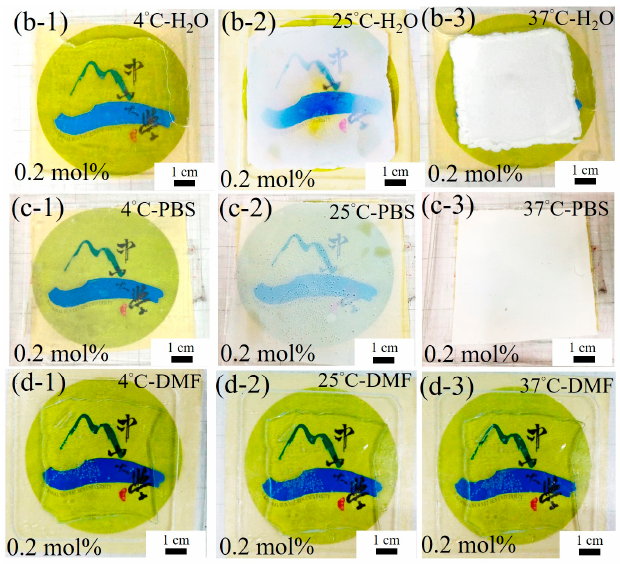
Figure 5. ( a ) Optical transmittance of poly(MEO 2 MA) hydrogel samples were measured as a function of temperature at 500 nm with the scan rate 2 °C min − 1 . ( b – d ) The transmittance changes of poly(MEO 2 MA) hydrogel pads were characterised in Milli-Q water, phosphate buffered saline (PBS), and dimethylformamid (DMF) solution under the temperatures of 4 °C, 25 °C, and 37 °C, respectively.